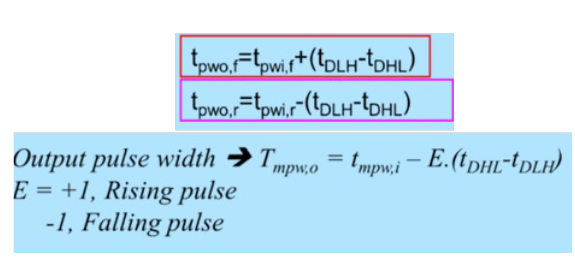
Figure 16. Calculation of propagated output pulse width